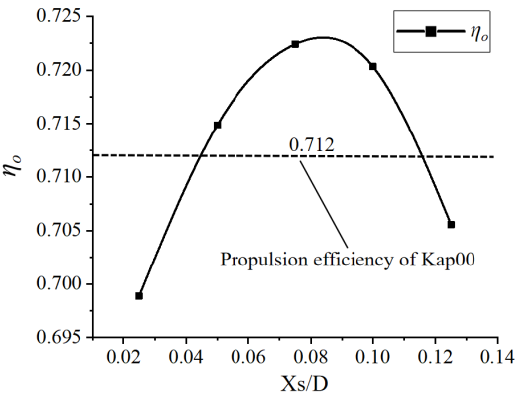
Figure 11. Change in propulsion efficiency with tip rake ( J = 0.8).